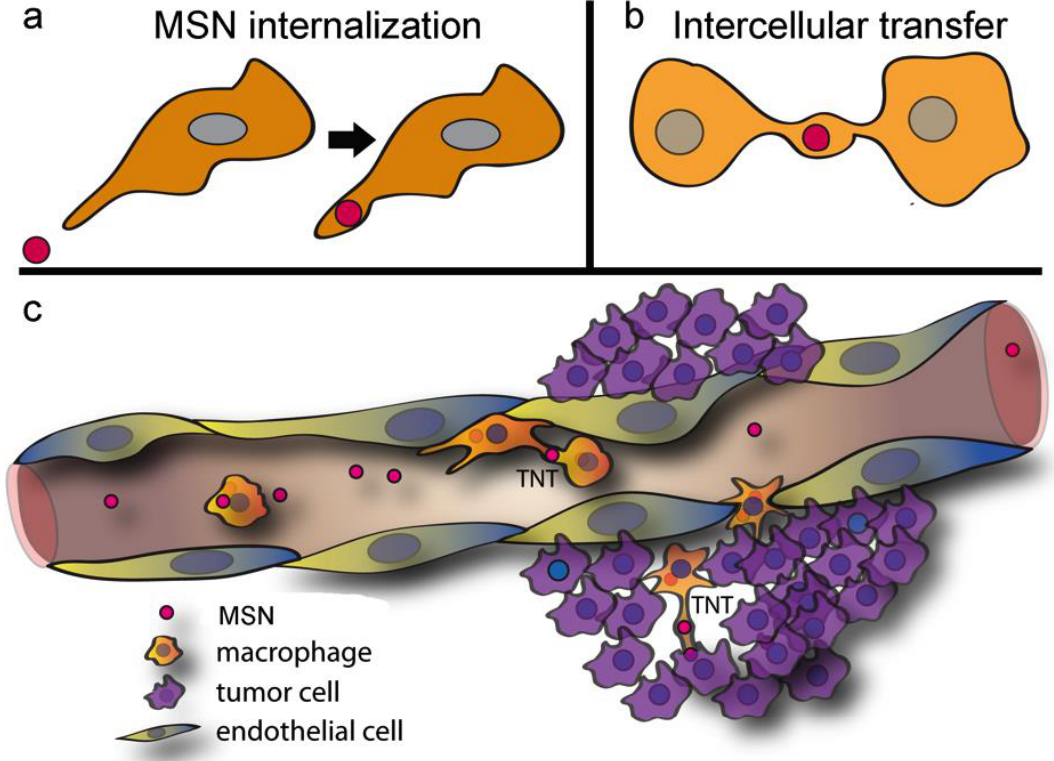
Figure 1. Proposed in vivo trafficking of mesoporous silica nanoparticle (MSN) to the tumor microenvironment. ( a ) MSN administered intravenously was rapidly internalized by systemic macrophages. ( b ) Macrophages are highly dynamic and interactive, with intercellular connections, known as tunneling nanotubes (TNT), enabling direct cell-to-cell transfer of MSN to neighboring or distant cells. ( c ) Proposed movement of MSN to the tumor microenvironment.